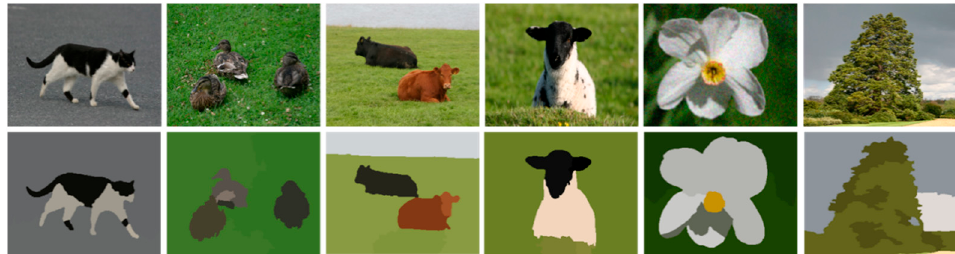
Figure 4. Single and multiple objects segmentation using MFCS. The 1st row shows the original while the 2nd row shows the segmentation results.